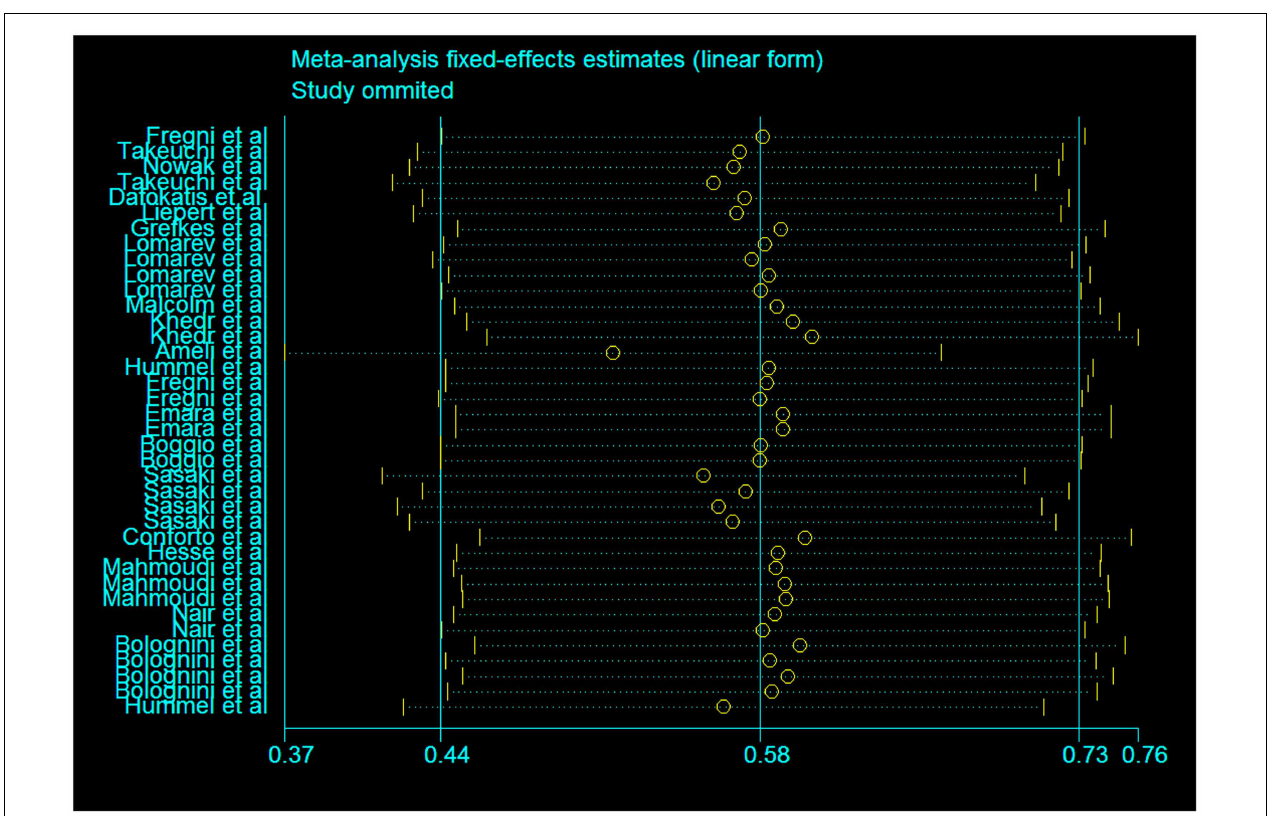
FIGURE 2 |Assessment of the fixed effects size estimates in linear form with effect size as Cohen’s d (standard mean difference) and employing error bars to represent the 95% confidence